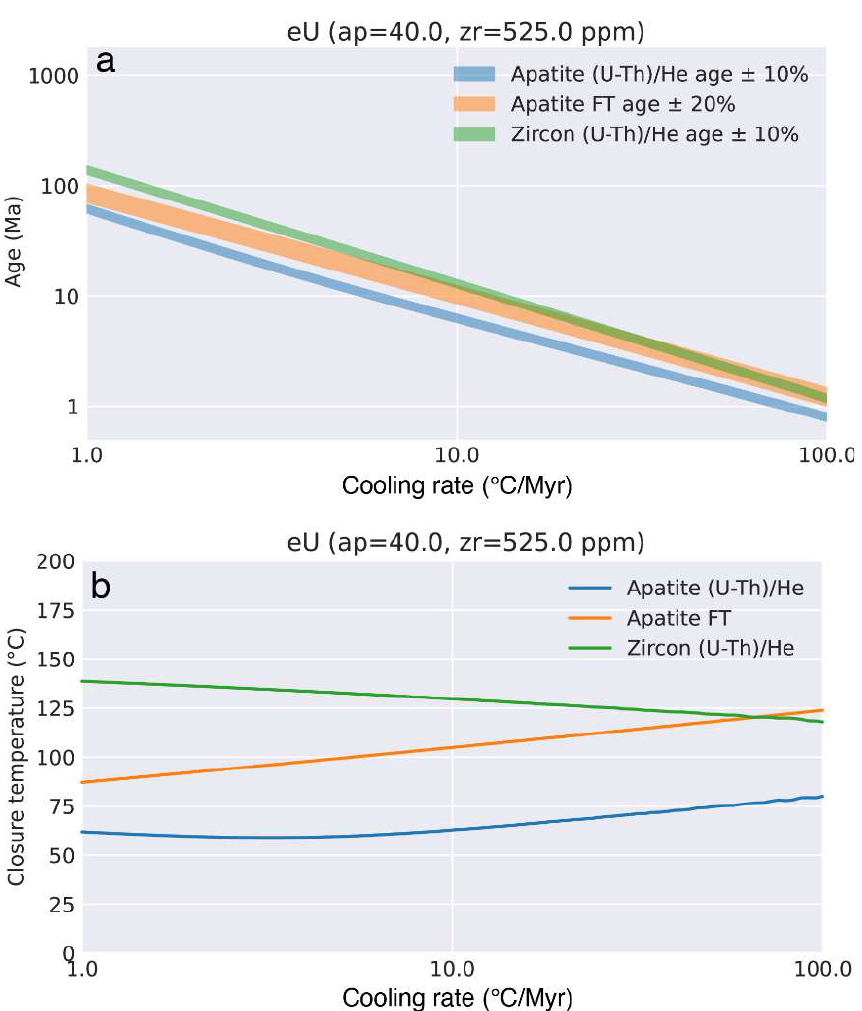
Figure 4. Predicted thermochronometer ages ( a ), and closure (or annealing) temperatures ( b ) for our samples. The model parameters are based on the mean values of our samples: the eU concentration is 40 µg/g for apatite and 525 µg/g for zircon, the ESR is 65 µm and 60 µm for apatite and zircon grains respectively. The plots were made with thermochron_plotter [43] and comprise 1203 forward models.